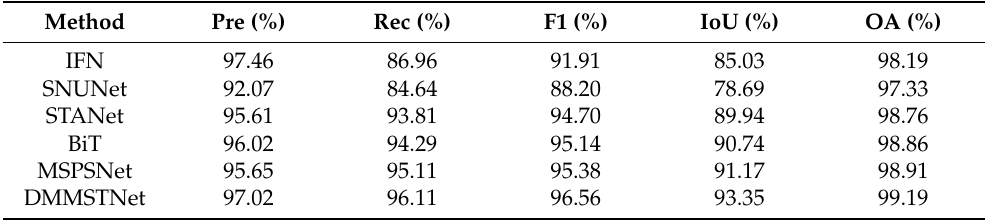
Table 2. Numerical Results on CCD Dataset.